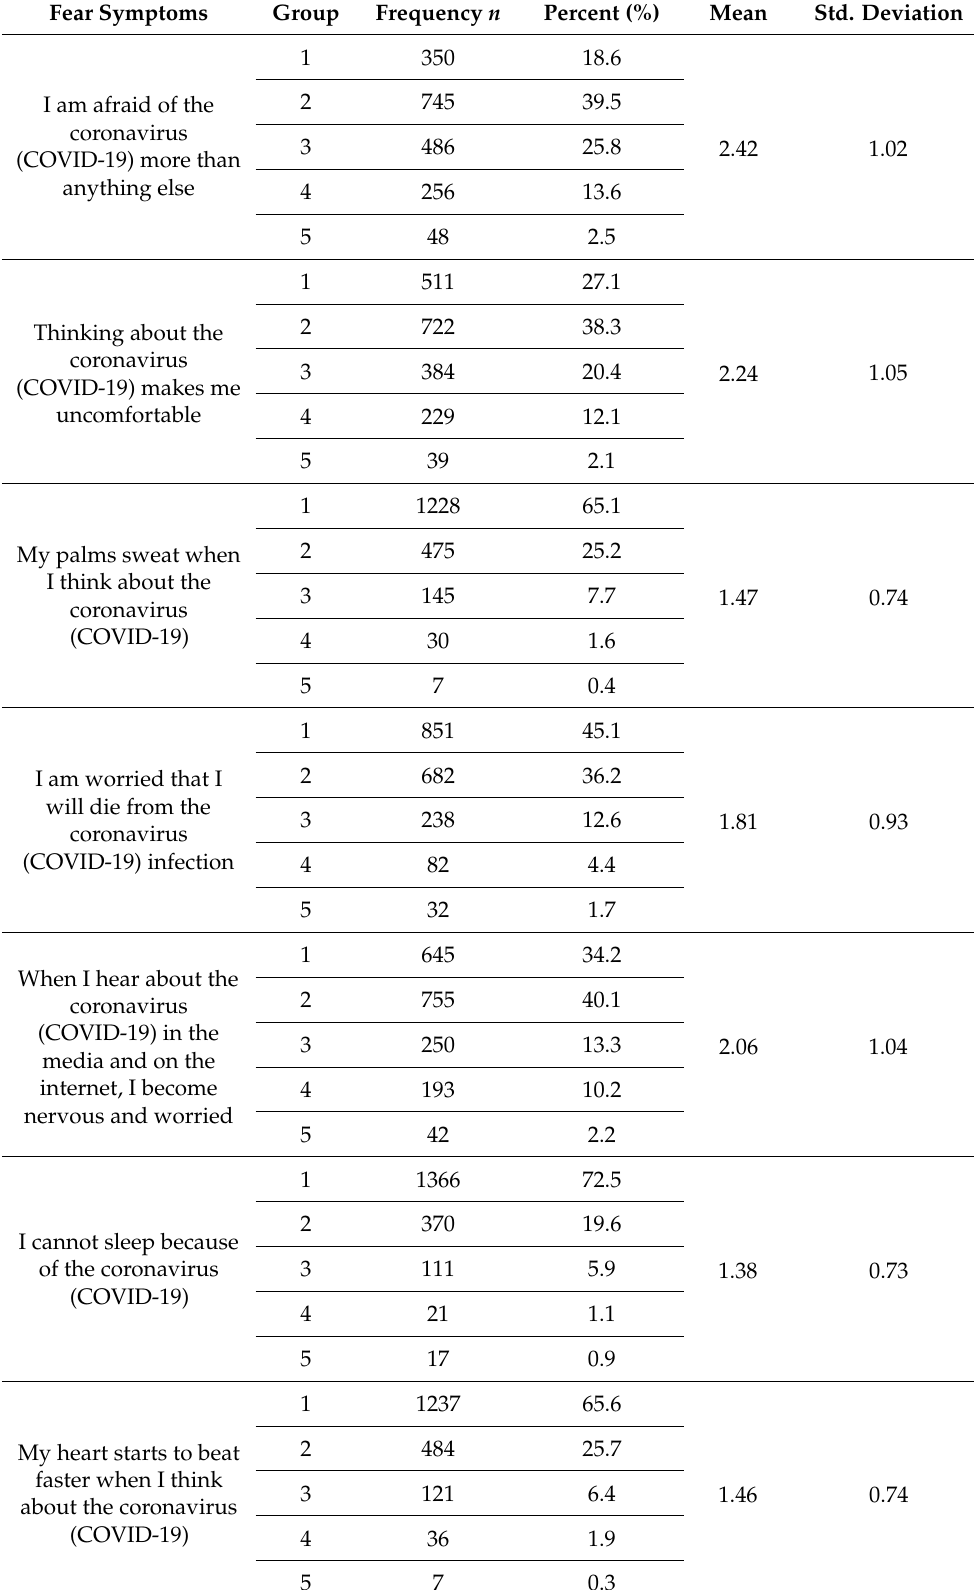
Table 3. Distribution of answers to individual